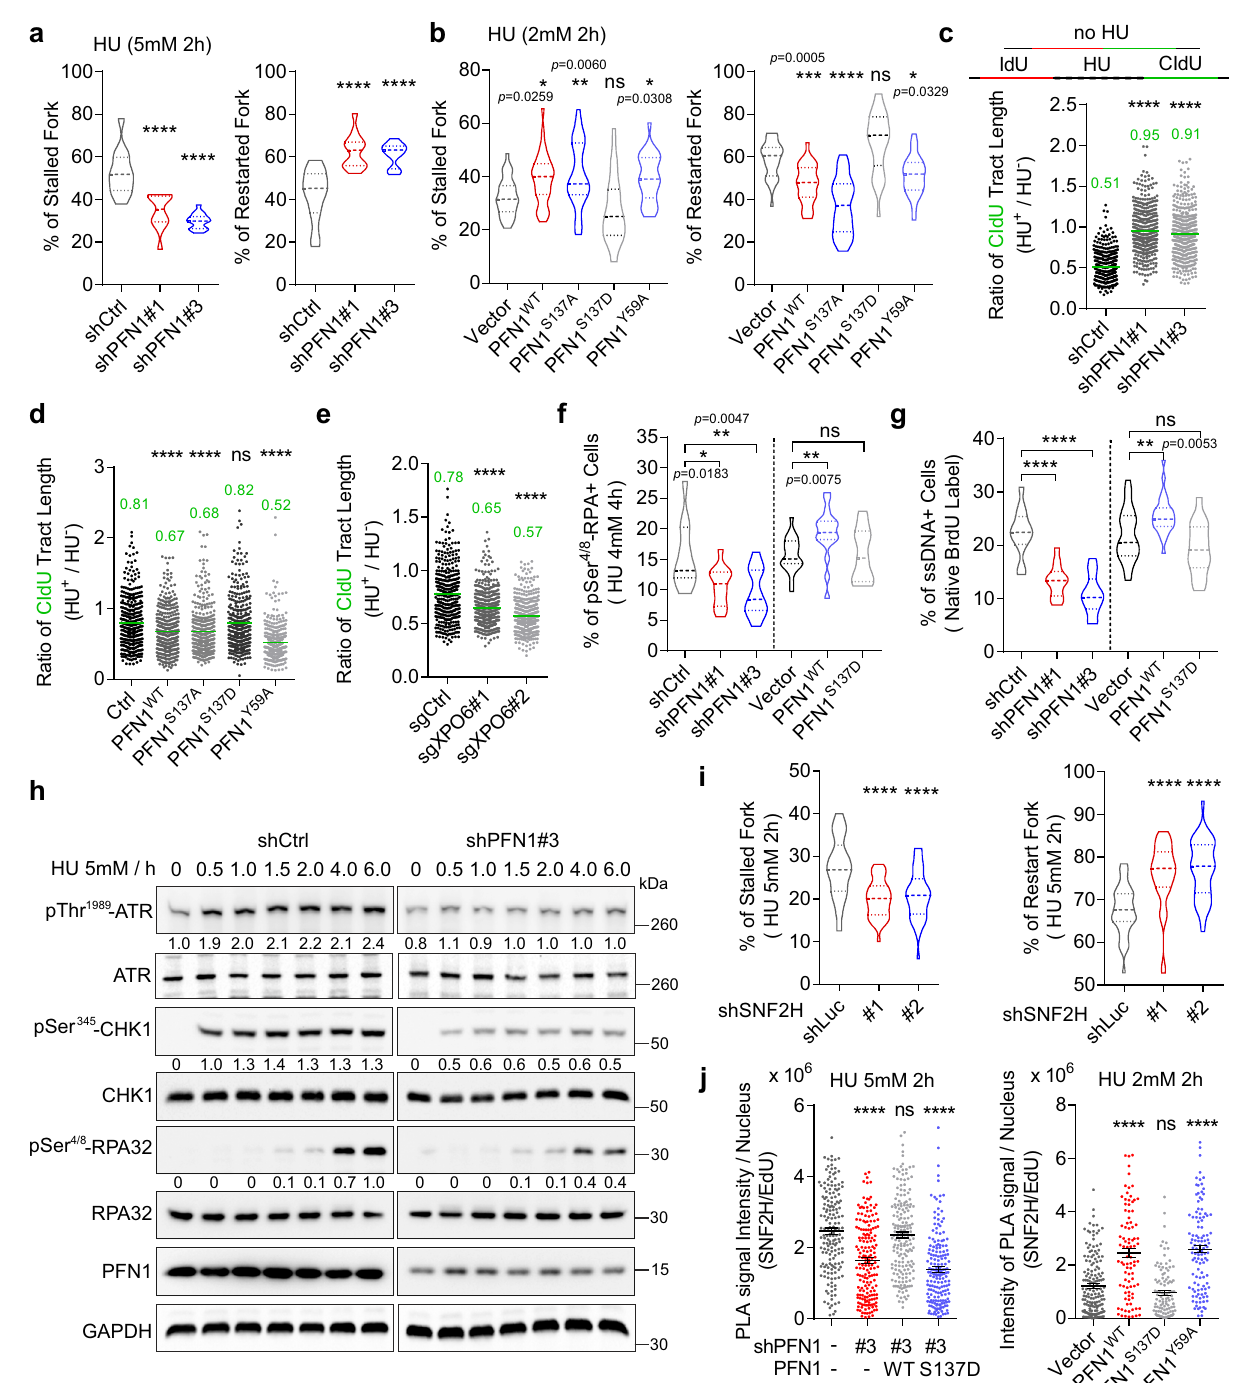
(Mirin) 60 and DNA2 (C5) 61 , two main DNA nucleases involved in stalled fork resection, signi fi cantly rescued PFN1-induced nascent DNA degradationwith C5 being more effective thanMirin(Fig. 4d). Further, similar to untagged PFN1 overexpression and XPO6 knockdown, NLS- PFN1, in a PLP-dependent manner, increased HU-induced nascent DNA degradation while NES-PFN1 showed no effect (Fig. 4e). Thus, nuclear PFN1 promotes nascent DNA degradation at stressed replica- tion